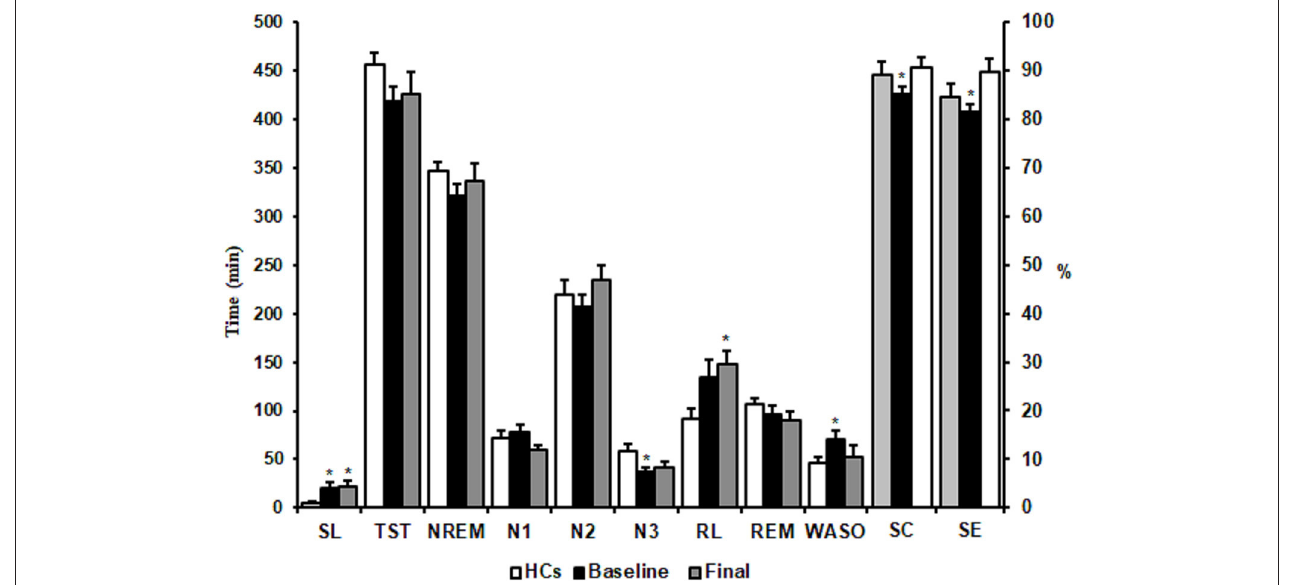
FIGURE 2 | Effects of escitalopram on sleep architectures. SL, sleep latency; TST, total sleep time; NREM, non-rapid-eye-movement; RL, REM sleep latency; REM, rapid-eye-movement; WASO, wake after sleep onset; SE, sleep efficiency; SC, sleep continuity. The data are expressed as mean ± SE. n = 13 MDD patients. n = 13 healthy controls. * p < 0.05, different from healthy controls. HCs, healthy controls; Baseline, MDD patients before treatment; Final, MDD patients at the end of 8 weeks of escitalopram treatment.